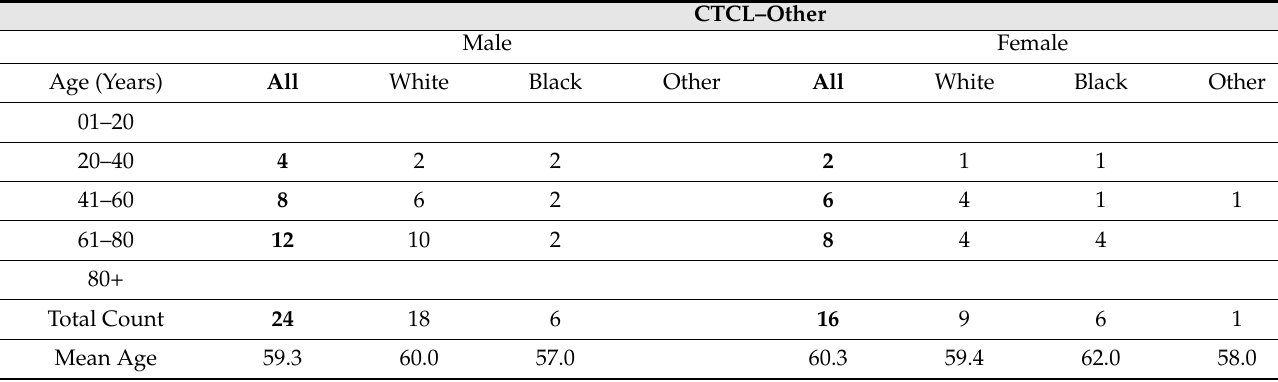
Table 2. Age-specific incidences of CTCL by sex and age at